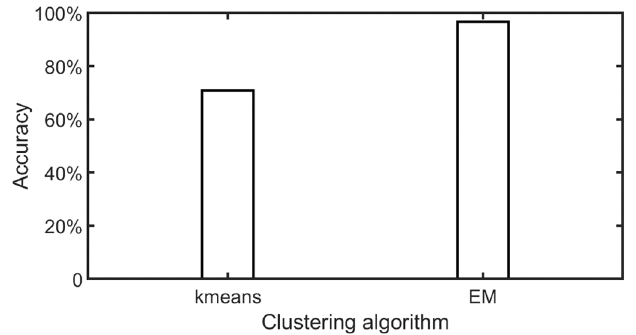
Figure 12. Clustering accuracy of different clustering methods.